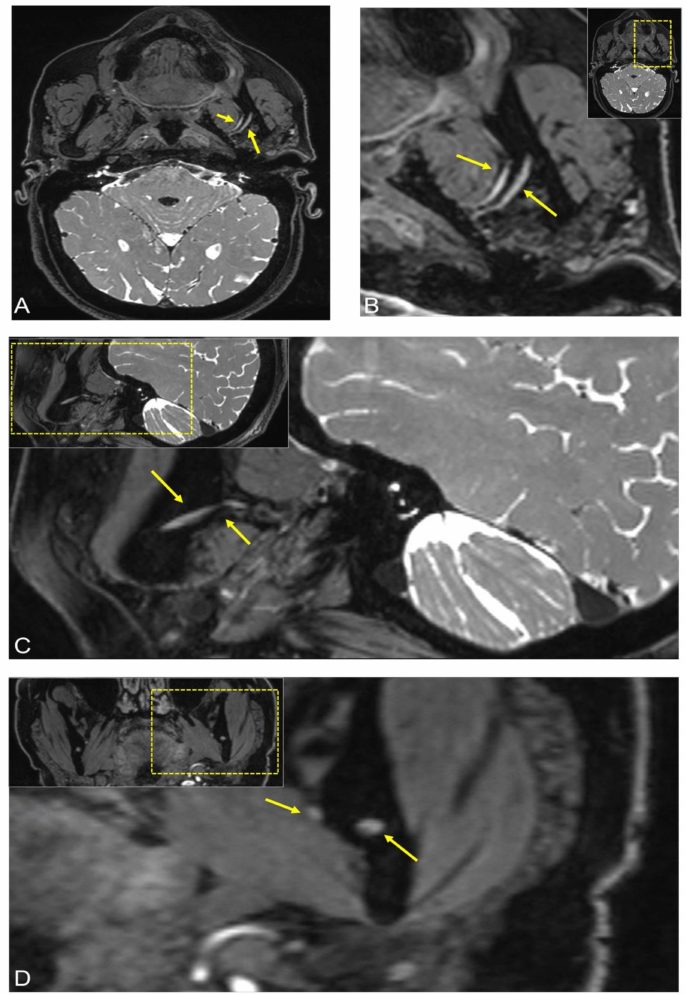
Figure 2. Follow-up MRI after three months of the same patient. The 3D Double-Echo Steady State (DESS) MRI protocol revealed the following: ( A , B ) Axial, ( C ) sagittal, and ( D ) coronal side-by-side comparison of the image reconstructions showed bilateral symmetry of the mandibular nerve with a loss of signal intensity in the 3D-DESS sequence compared with the previous examination, no longer indicating evident pathological signal alterations. In all images, the short arrow shows signal hyperintensities of the lingual nerve at the anatomic point where it begins to pass from lateral to medial and the longer arrow represents the inferior alveolar nerve before it enters into the mandibular foramen. For orientation, the dotted rectangles in the corner show the enlarged